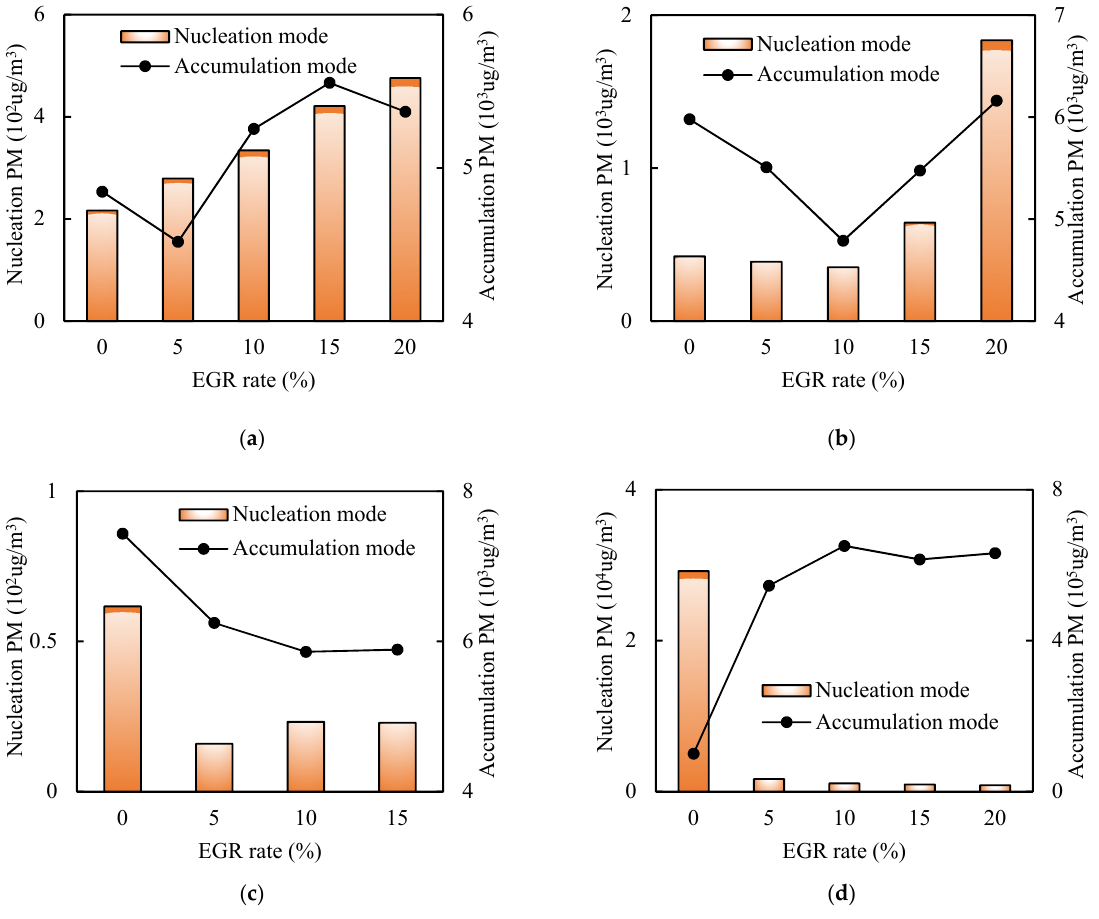
Figure 10. The law of nuclear and accumulated particle mass concentration changes with EGR. ( a ) 2000 r/min 10 bar; ( b ) 2000 r/min 15 bar; ( c ) 4000 r/min 10 bar; ( d ) 4000 r/min full load. As shown in Figure 11, as the EGR rate increased, the total PM concentration did not At 2000 r/min 10 bar and 2000 r/min 15 bar, the mass concentration of accumulation greatly change. Under the full load of 4000 r/min, the total PM concentration increased mode particles firstly decreases and then increases with the rate of EGR, which is consistent after adding EGR. As EGR continued to increase, the PM concentration basically remained with the change in the peak number concentration of accumulation mode particles under unchanged. Moreover, in general, after adding EGR, the number of large-size particles this working increased.